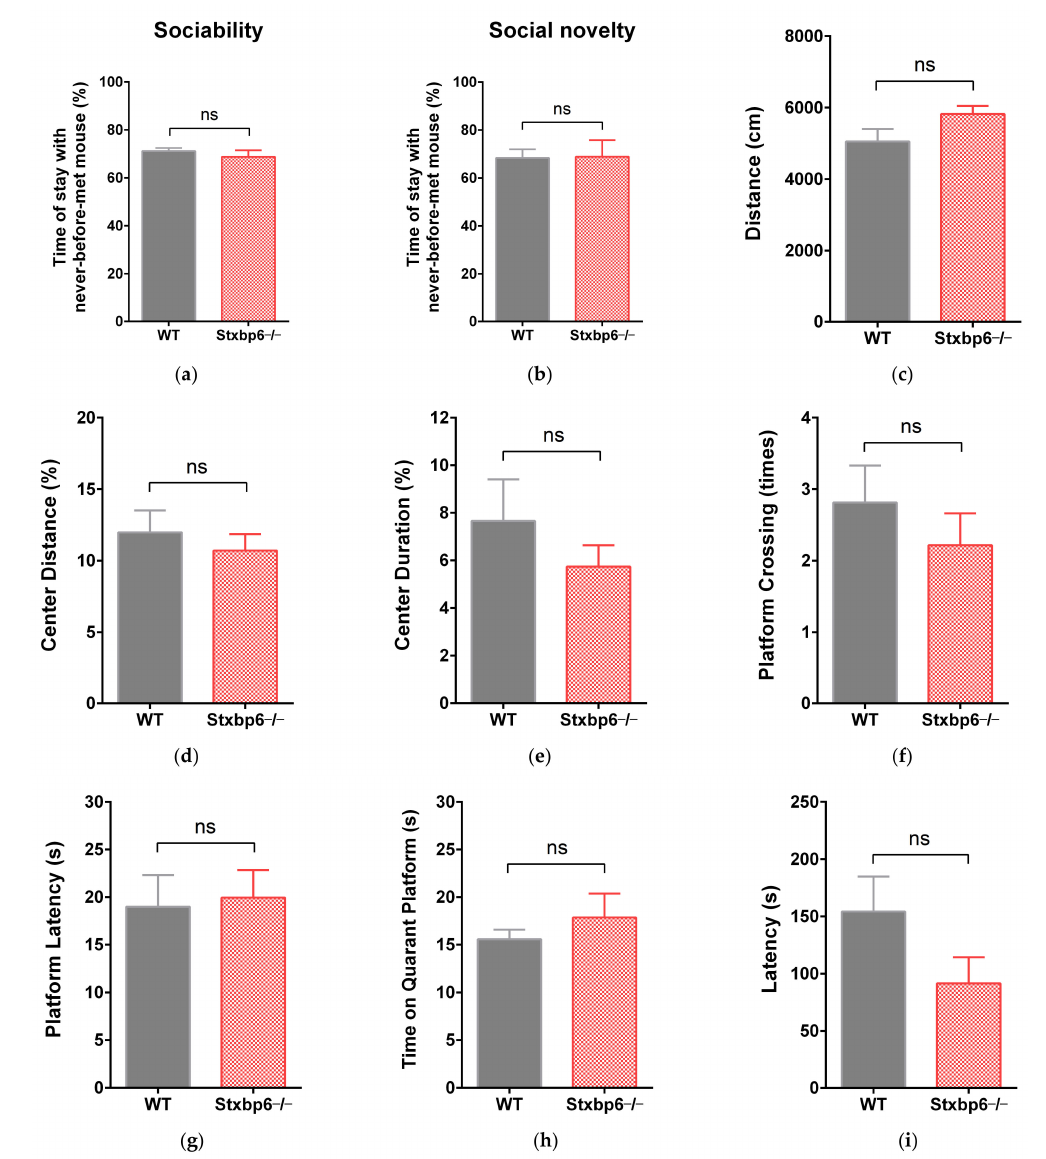
Figure 2. Behavioral analyses of Stxbp6-knockout mice. ( a ) Time (%) with the new stranger spent by Stxbp6 − / − mice was not significantly different compared to that by WT mice (WT: 71.15 ± 1.307, Stxbp6 − / − : 68.75 ± 2.726; p = 0.4427) in the sociability stage of the three-chamber test ( b ) or in the social novelty stage (WT: 68.35 ± 3.631, Stxbp6 − / − : 68.83 ± 6.994; p = 0.9522); ( c ) The open field test was used to evaluate the general activity levels of the mice. No difference was observed in total distance moved (WT: 5052 ± 348.3, Stxbp6 − / − : 5819 ± 228.0; p = 0.0743), ( d ) percentage of distance spent in the central area (WT: 11.98 ± 1.533, Stxbp6 − / − : 10.71 ± 1.149; p = 0.5116), ( e ) or percentage of time spent in the central area (WT: 7.656 ± 1.750, Stxbp6 − / − : 5.740 ± 0.8922; p = 0.3287) between WT and Stxbp6 − / − mice; ( f ) The following parameters in the Morris water maze were assessed: number of platform crossings in the target quadrant (WT: 2.813 ± 0.517, Stxbp6 − / − : 2.2140 ± 0.448; p = 0.4045), ( g ) the latency in finding the platform (WT: 18.99 ± 3.326, Stxbp6 − / − : 19.96 ± 2.893; p = 0.8317), ( h ) and time spent in the target quadrant (WT: 15.58 ± 1.012, Stxbp6 − / − : 17.86 ± 2.519; p = 0.3930); ( i ) Latency to fall was recorded in constant-speed mode in the rotor-rod test, and no significant difference was found between WT and Stxbp6 − / − mice (WT: 154.2 ± 30.58, Stxbp6 − / − : 91.40 ± 22.98; p = 0.1145). Note: Data are shown as mean ± SEM, n ≥ 7 per group. Unpaired two-tailed Student’s t -test was used. ns, not